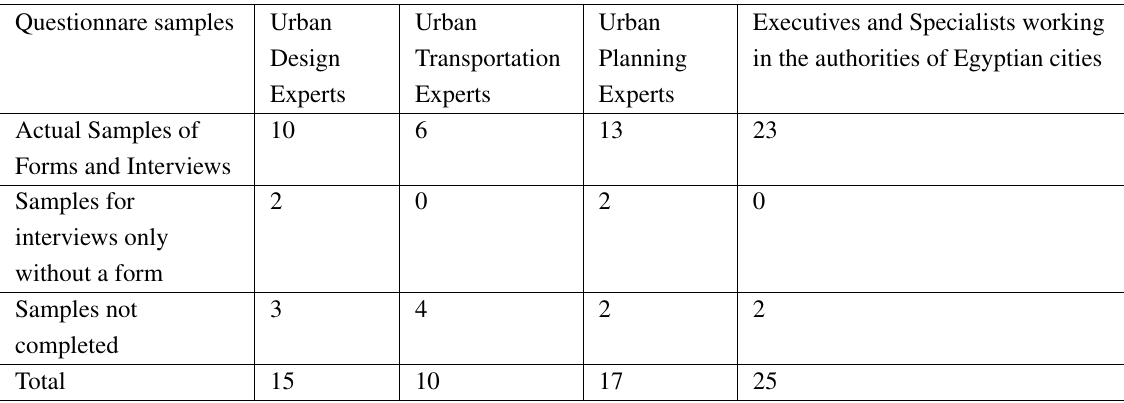
Table 1. Expert Samples Distribution in Phases I, II and III of the Questionnaire. Source: Samples of Forms and Interviews 2016 and